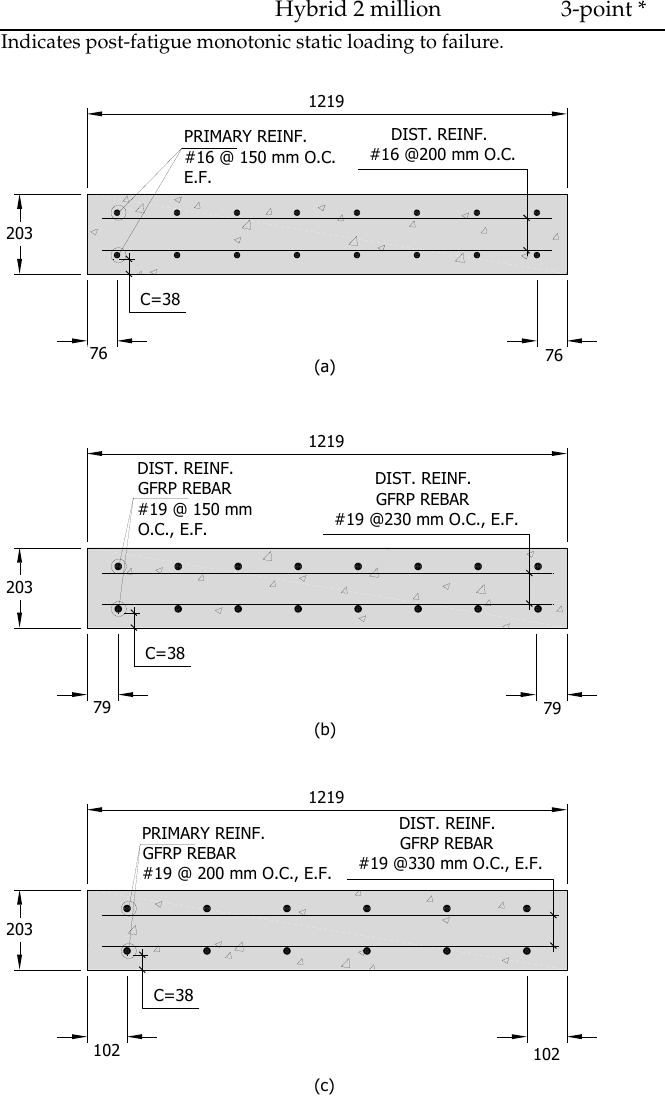
Table 2. Experimental testing matrix. Deck Reinforcement Type Steel